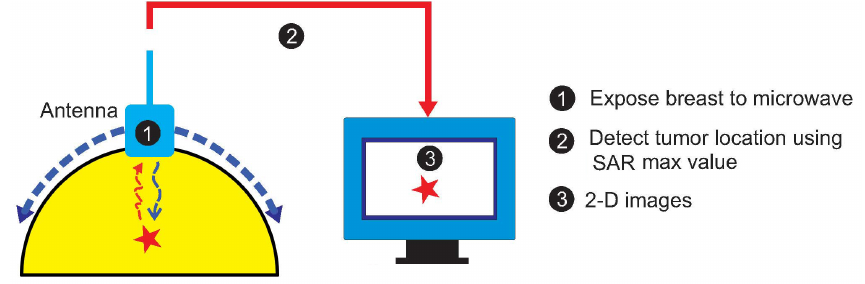
Figure 1. The concept of the considered breast-imaging system.